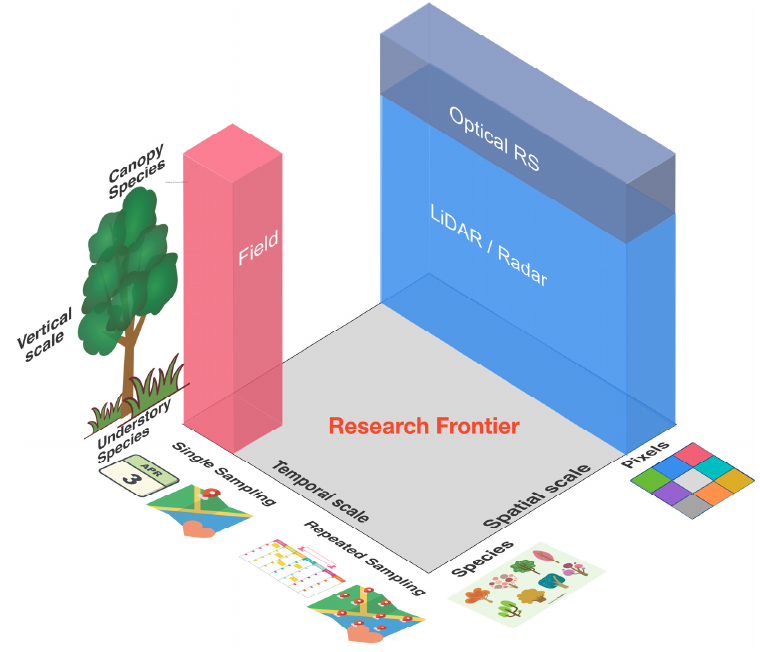
Figure 2. Identifying the Frontier in Satellite-Based Remote Sensing used for Plant FD Research Field measurement (red box) can resolve species details (including both canopy and understory) in a plant community but field data is confined in space and time. Optical satellites (dark blue box) can resolve top canopy layer traits but have limited penetration ability to resolve the vertical structure. Radar and LiDAR satellites (light blue box) can complement optical satellites to characterize the full 3D structure of a plant community. Satellites can repeat the measurements across space and time but can only take measurements at a pixel level and cannot (to date) resolve the species or even individual details. The new research frontier will be formed by moving the field measurements towards the right (more frequent sampling across space and time) while moving satellite measurements towards the top (more refined measurements so that we can resolve species details).